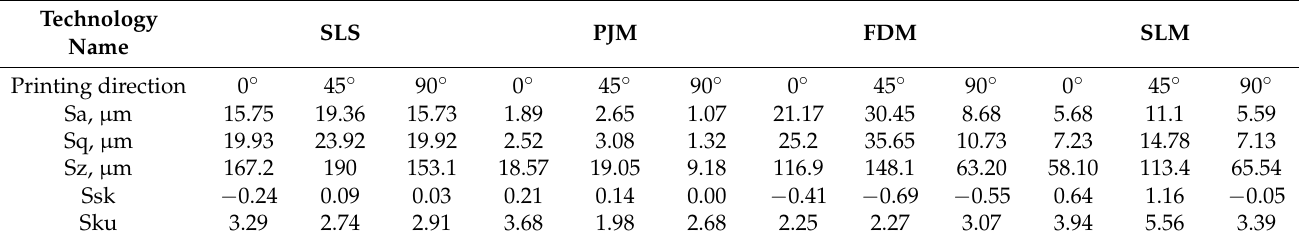
Table 3. Measurement results obtained for the Talysurf PGI optical profilometer 1230.